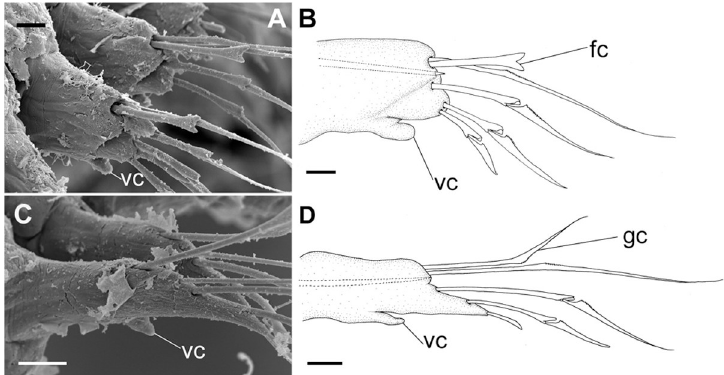
Fig 10. Meiodorvillea penhae sp. nov. (A,B) parapodia from anterior region; (C,D) parapodia from posterior region; all anterior view. Abbreviations: fc = furcate chaeta; gc = geniculate chaeta; vc = ventral cirrus. Scale bars: (A,C) = 15.6 μ m; (B,D) = 10 μ m.